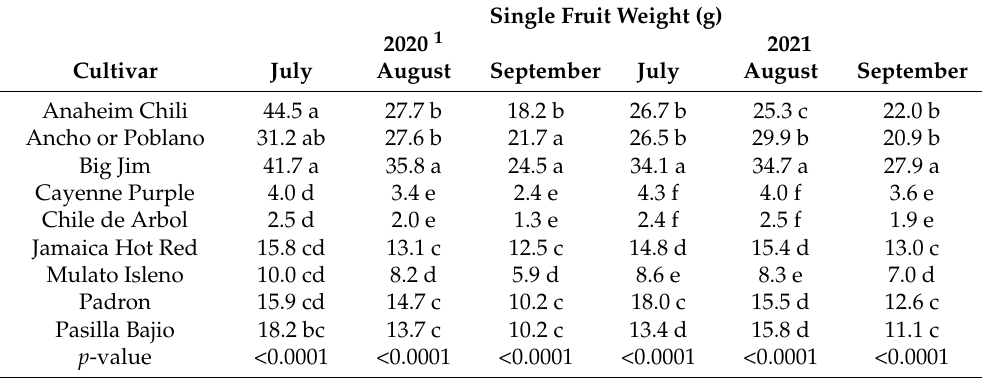
Table 4. Single fruit weight of nine heirloom chile pepper cultivars grown in a container production system in Starkville, Mississippi, during two growing seasons. Single Fruit Weight